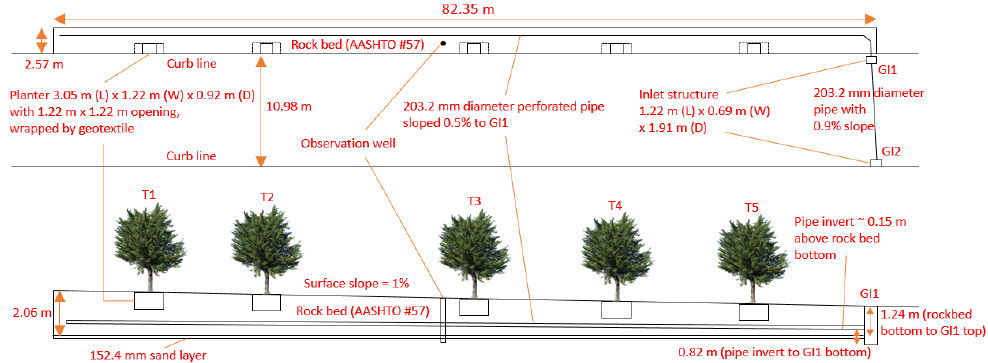
Figure 1. Plan view ( top ) and profile view ( bottom ) of the site under investigation.